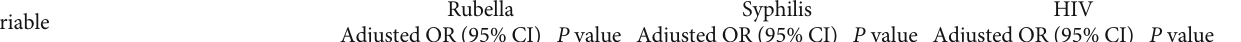
Table 5: Multivariate analysis of factors associated with rubella, syphilis, and HIV as MTCT